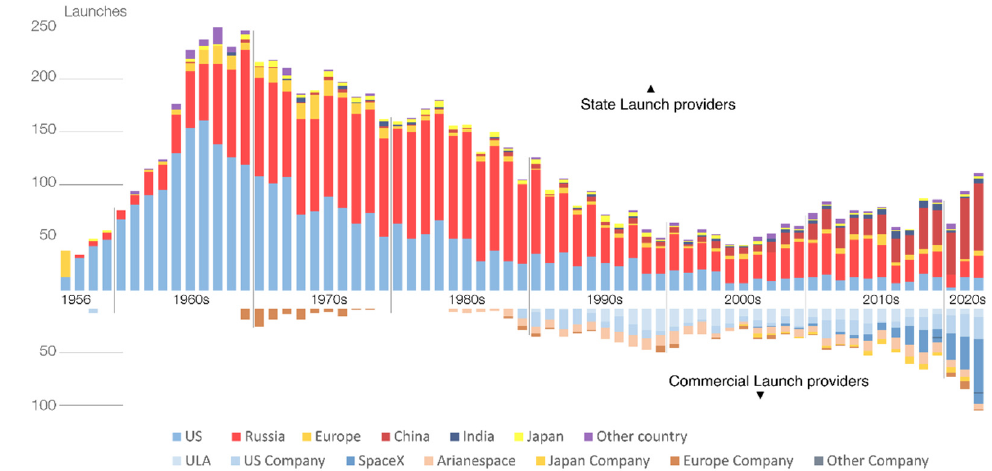
Figure 1. Orbital launches from 1956 to 2022 from the main operators. Inspired by [6].